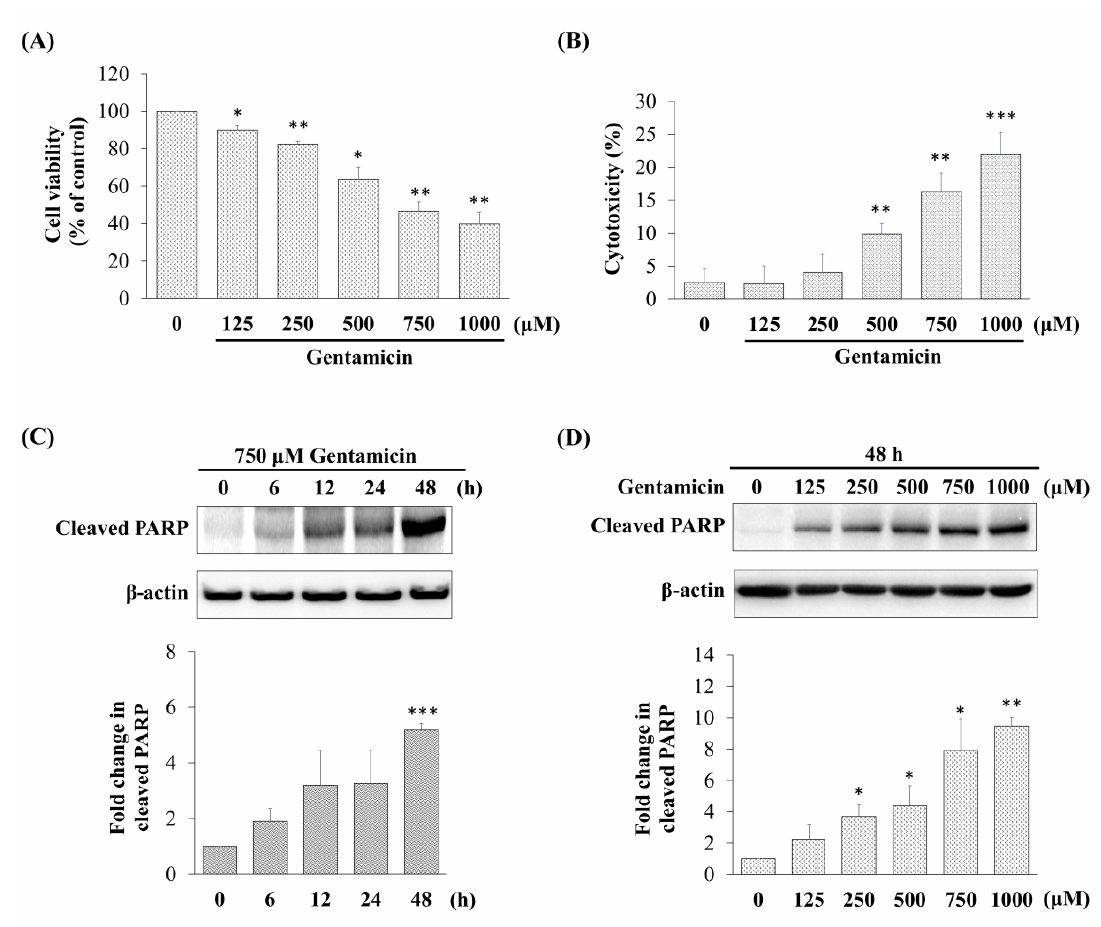
Figure 1. Effect of gentamicin on cell viability, cytotoxicity, and cleaved poly (ADP-ribose) polymerase (PARP) expression in mouse cochlear UB/OC-2 cells. The damage to the cells at various gentamicin concentrations (48 h) was assessed by ( A ) 3-(4,5-dimethylthiazol-2-yl)-2,5-diphenyltetrazolium bromide (MTT) assay and ( B ) lactate dehydrogenase (LDH) release assay. Relative expression levels of cleaved PARP detected by western blotting in cells treated with ( C ) 750 μM gentamicin at different exposure times and ( D ) different concentrations of gentamicin for 48 h. All data are expressed as the mean ± standard deviation from three independent experiments. * p < 0.05, ** p < 0.01, *** p < 0.001 vs. the control group.